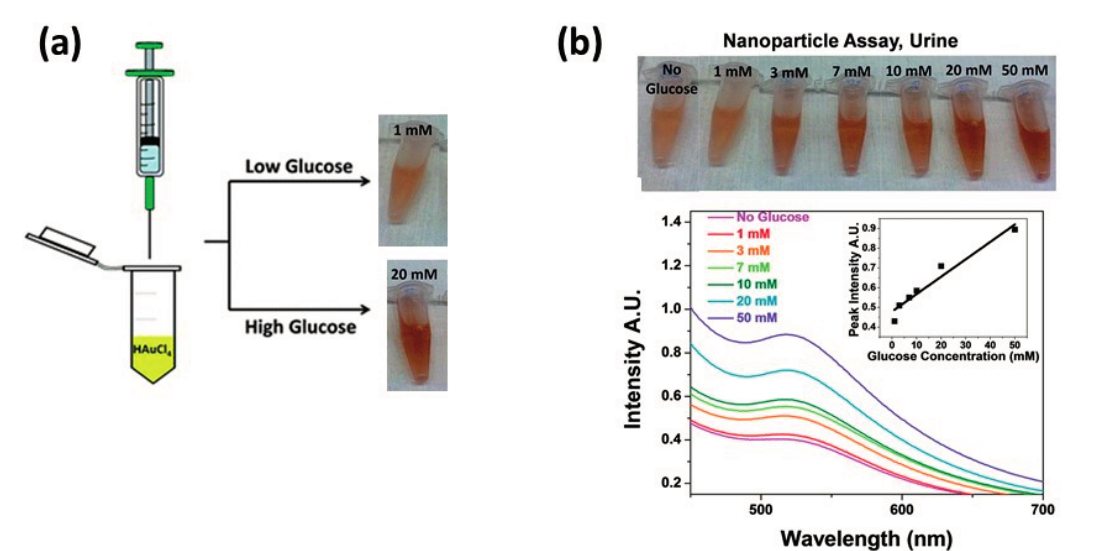
Figure 7. A schematic for glucose detection through nanoparticle formation, ( a ) that